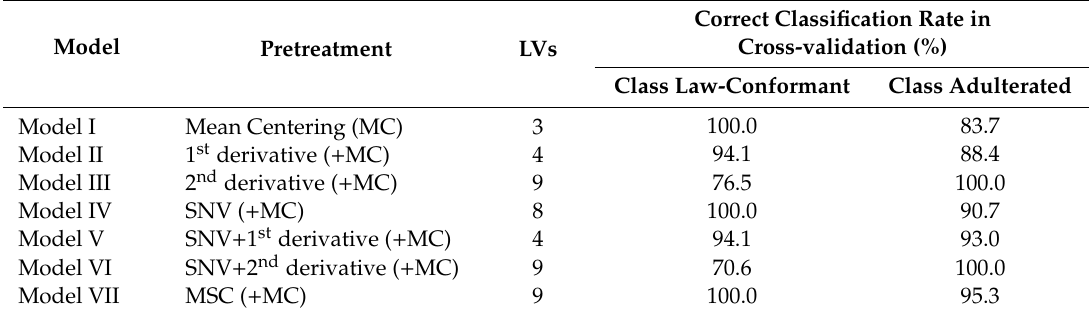
Table 3. Partial Least Squares Discriminant Analysis (PLS-DA) results on the calibration